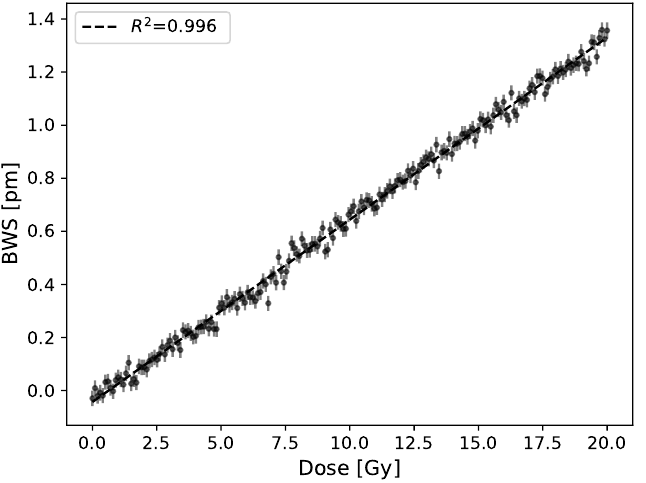
Figure 5. Bragg wavelength shift in terms of dose for a 20 Gy irradiation using a PMMA plate as coating (5.5 × 107.5 × 205 mm 3 ) and 6 MV beam. The response to dose is 0.070 ± 0.006